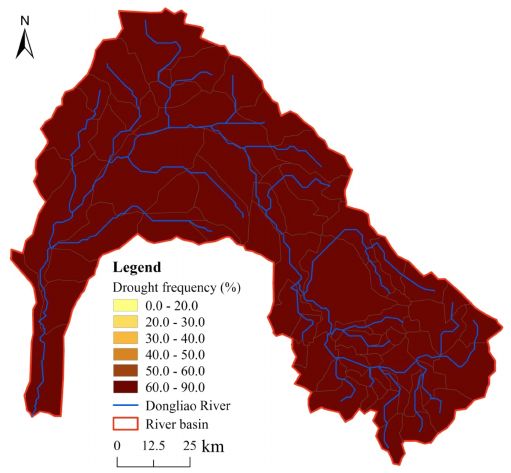
Figure 17. Spatial distribution of drought frequency simulated by the RWD in the